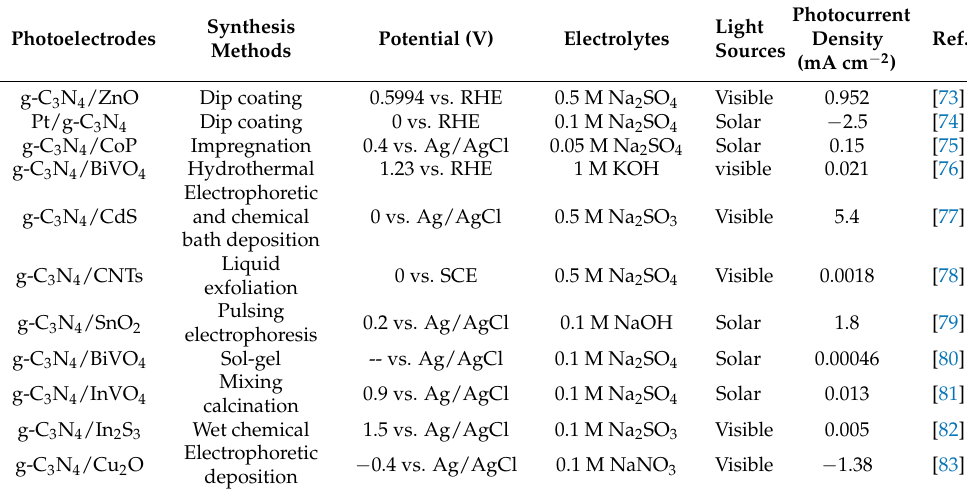
Figure 6. ( a ) Formation mechanism of NNO/CN heterostructured material, ( b ) XRD patterns, ( c ) TEM image of NNO/CN heterostructured material, ( d ) optical absorption spectra, ( e ) Nyquist plots, ( f ) I-t curves, and ( g ) charge transfer mechanism of the NNO/CN heterostructured electrode. Reprinted with permission from reference [31], Copyright 2020, IOP. Table 1. The PEC performance of g-C 3 N 4 -based binary heterostructured